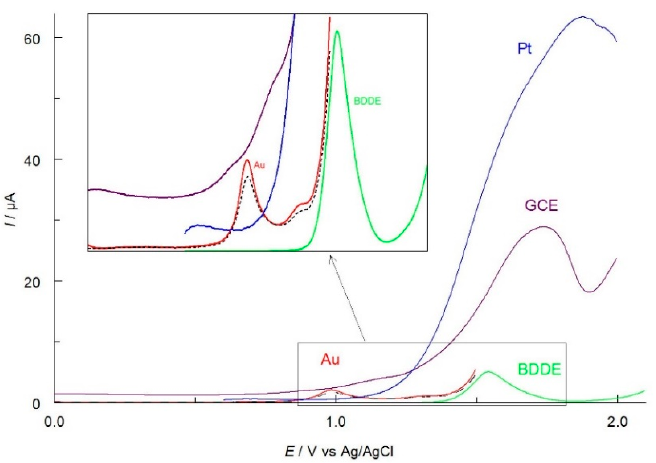
Figure 2. Comparison of DPV curves (d E = 20 mV) recorded in C-PB buffer (pH 5.6) containing MIT (10.38 mg L − 1 ) on different electrode materials (each Φ = 3 mm, given in the curves). The dashed line shows the curve recorded for the supporting electrolyte on the gold electrode.